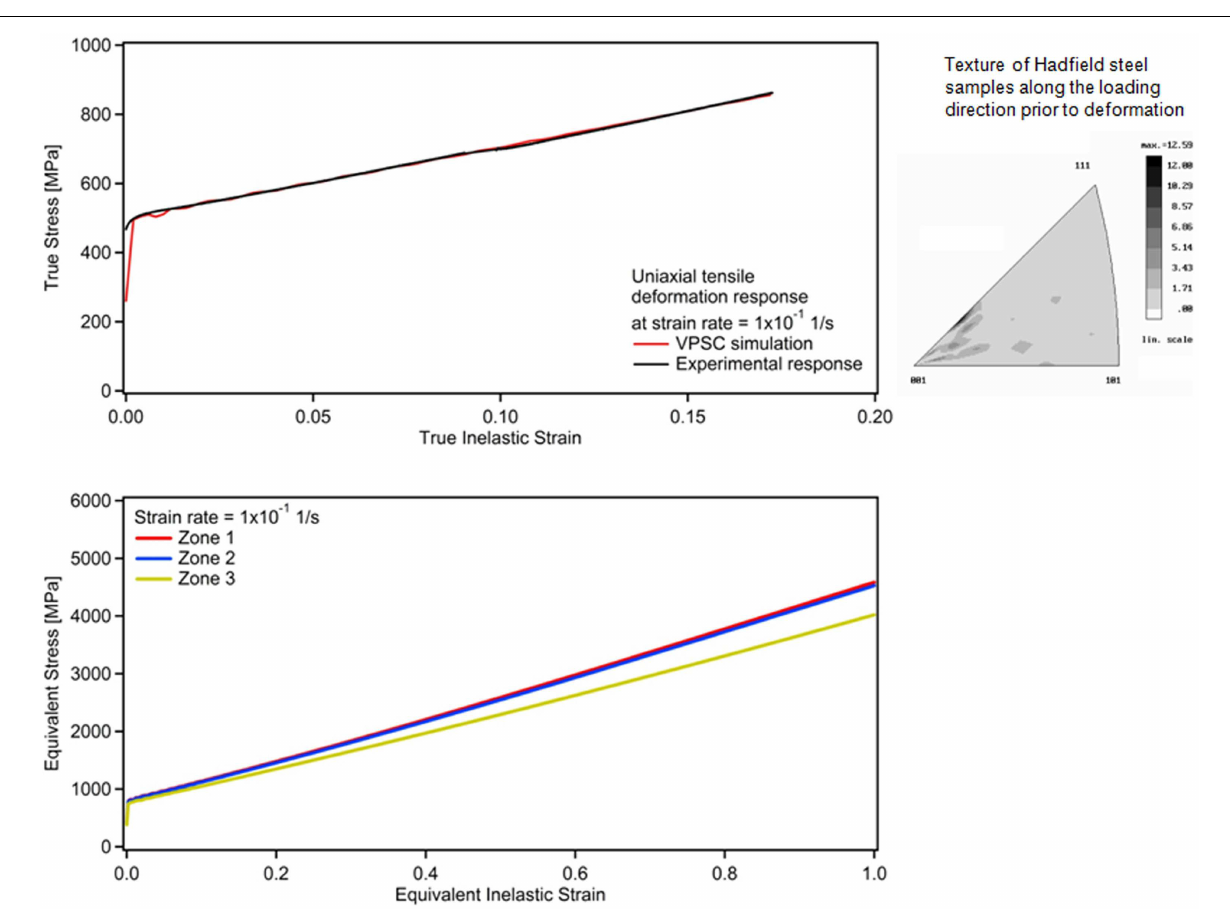
FIGURE 5 |Top:VPSC simulation of the RT experimental uniaxial tensile deformation of Hadfield steel at a strain rate of 1 × 10 − 1 1/s, and the corresponding initial texture along the loading direction (representative